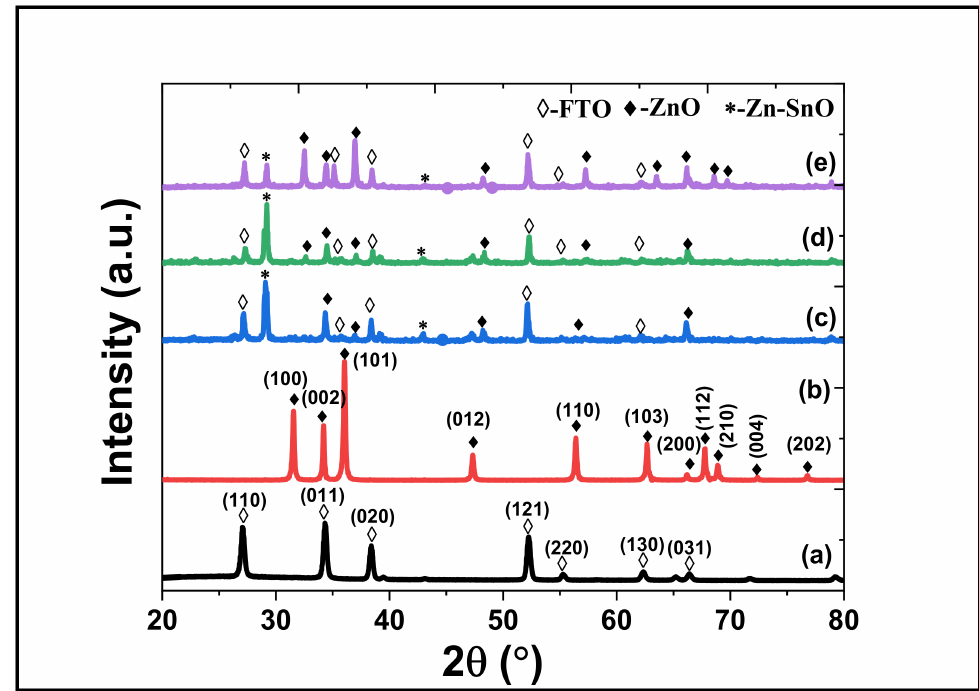
Figure 3. X-ray diffraction pattern of ( a ) FTO, ( b ) raw ZnO powder, ( c ) AZ-I, ( d ) AZ-II and ( e ) AZ-III